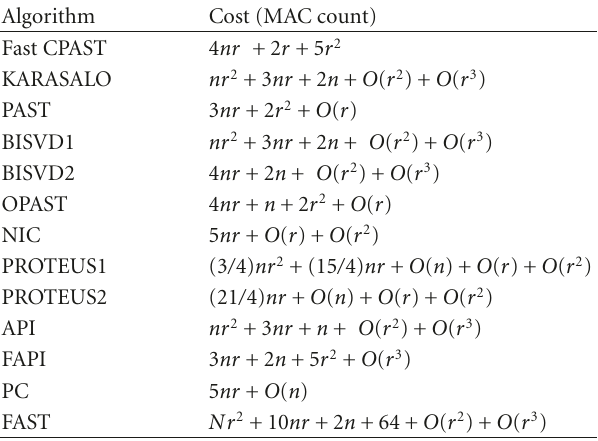
Table 6: Subspace tracking algorithms used in the simulations and their